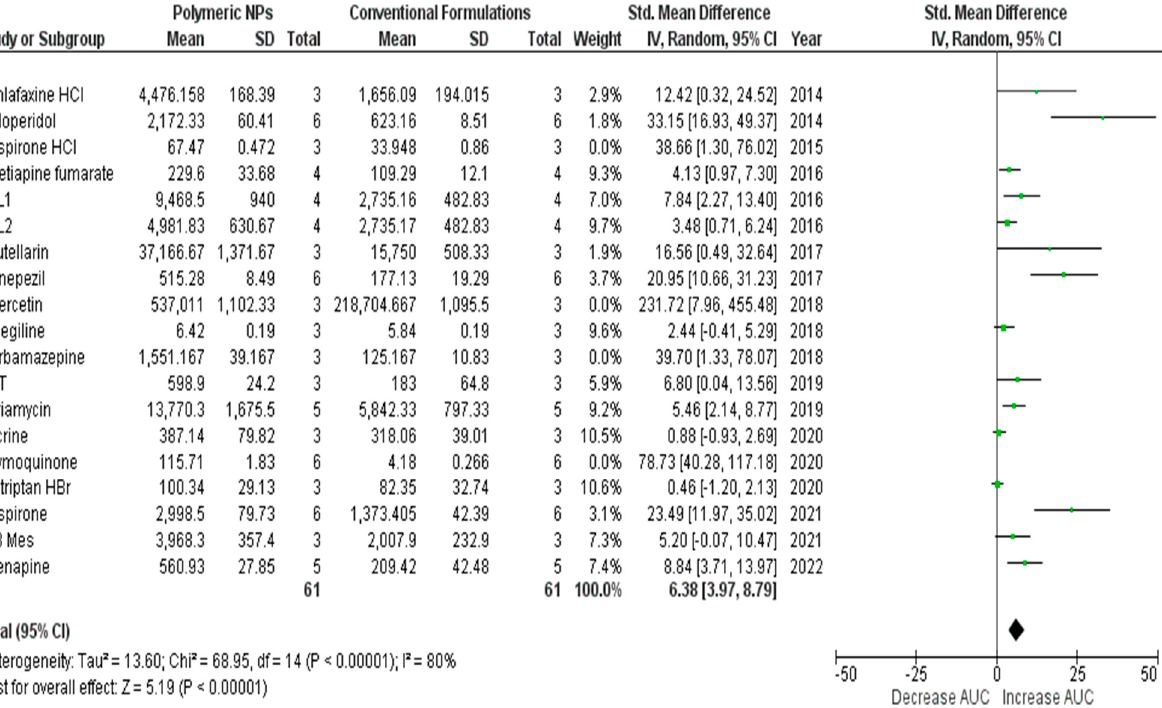
Figure 4. Forest plot of optimized meta-analysis for the studies: [1–3,5–8,11–17,19], according to OpenMetaAnalyst software.